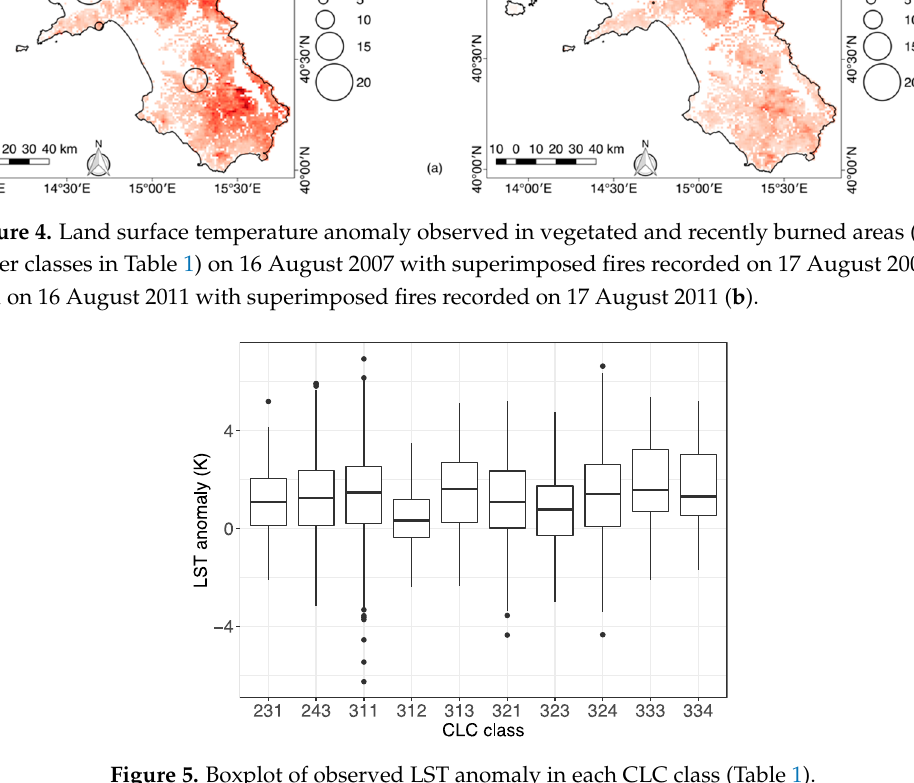
Figure 5. Boxplot of observed LST anomaly in each CLC class (Table 1).